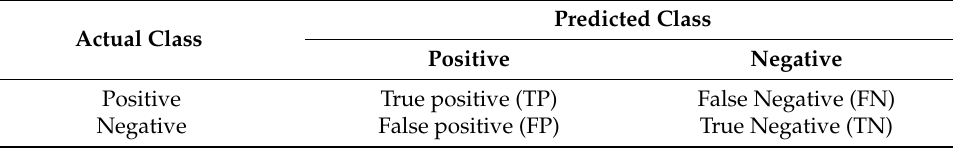
Table 9. Confusion matrix for evaluating machine